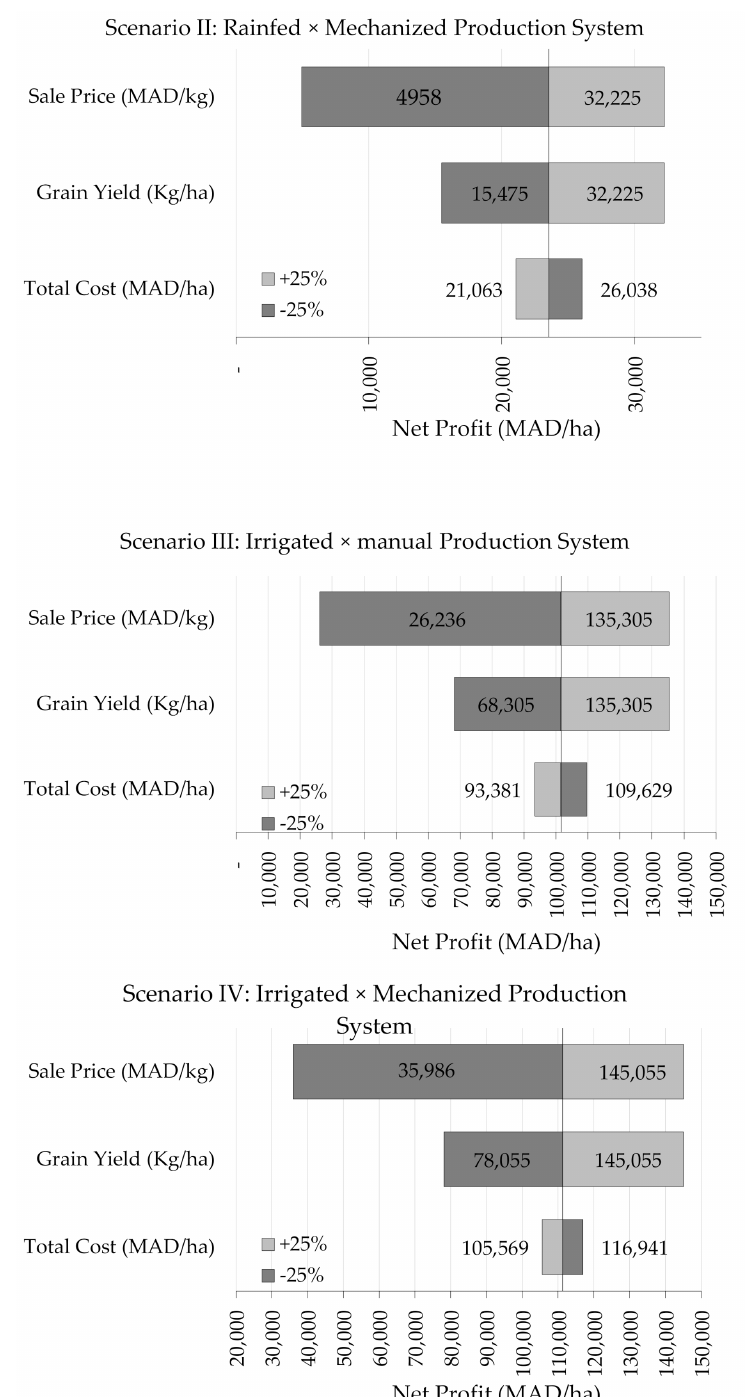
Figure 4. Changes in net profit as responses to ± 25% variation in sale price, grain yield and total cost under tested production scenarios. 1 USD = 9